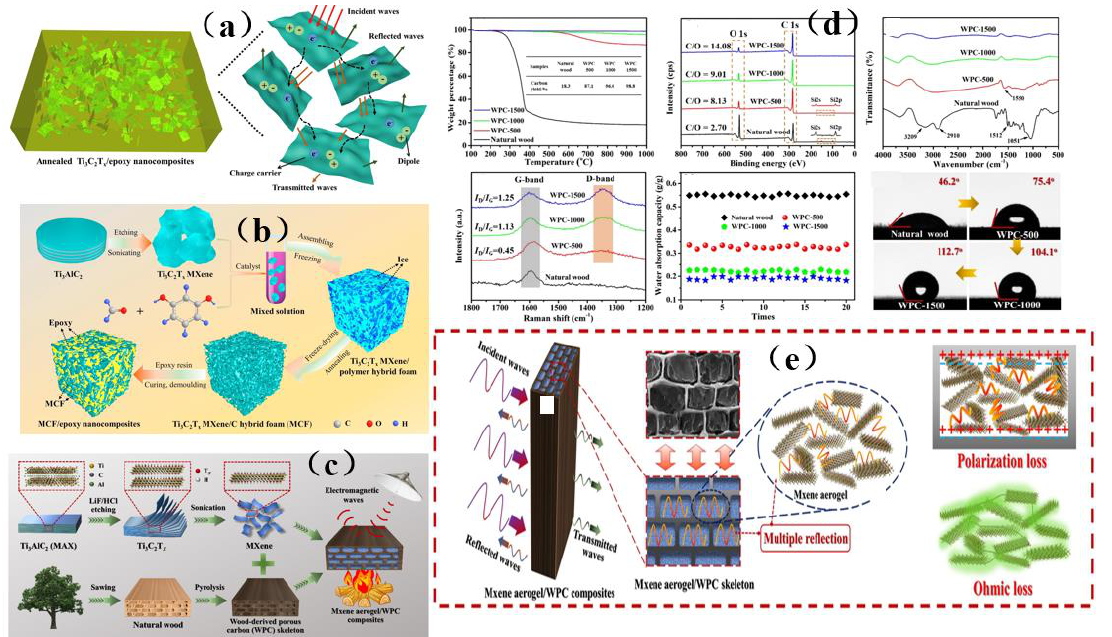
Figure 15. ( a ) Schematic diagram of shielding mechanism of annealed Ti 3 C 2 T x /epoxy resin elec- tromagnetic interference shielding nanocomposite [130]. Copyright 2019, Elsevier. ( b ) Schematic diagram of preparation process leading to a MCF/epoxy electromagnetic shielding nanocompos- ite [131]. Copyright 2019, Elsevier. ( c ) Schematic diagram depicting the preparation depicting